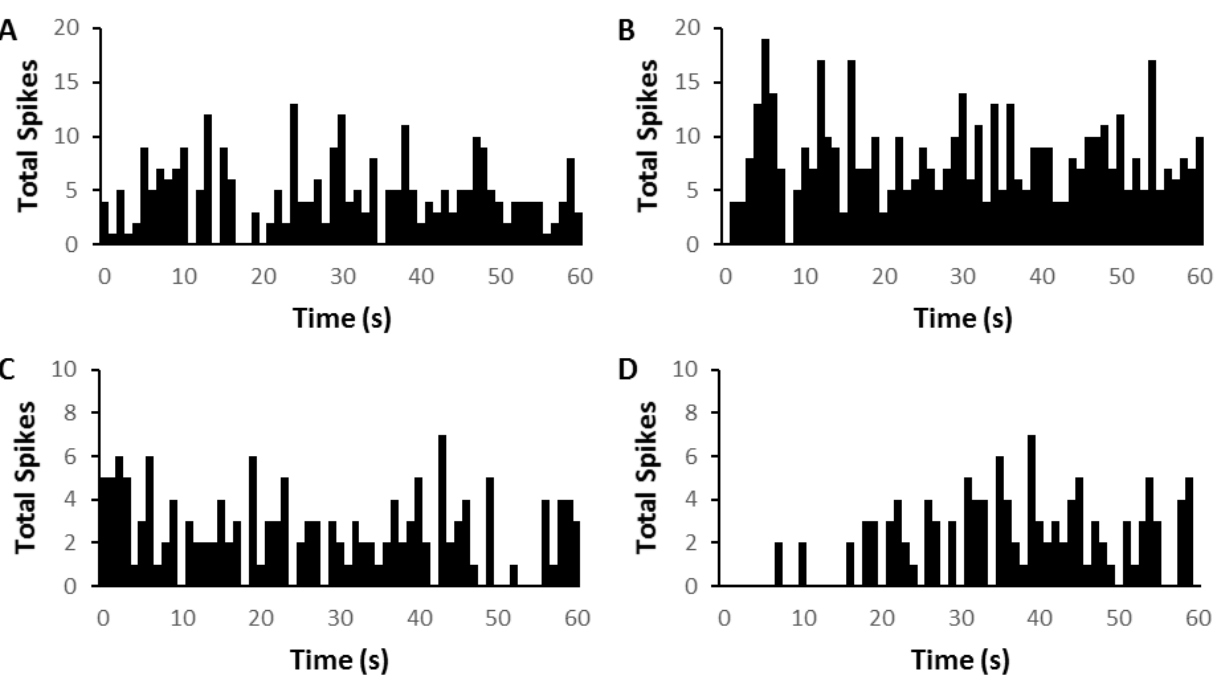
Figure 3. Time histograms showing two examples of medial geniculate nucleus (MGN) neuron firing in silence before (left column, ( A , C ) and after (right column ( B , D )) prolonged electrical stimulation of prefrontal cortex (PFC). ( A , B ) Onset response neuron(CF = 6.9 kHz; threshold = 37 dB) showing an immediate increase in firing followed by a general increase in overall firing after PFC electrical stimulation ( C , D ) Onset response neuron (CF = 10.5 kHz; threshold = 32 dB) showing decrease in firing after PFC electrical stimulation. Electrical stimulation by shock trains (pulse duration 0.5 ms, train duration 2 min, rate 200 Hz).